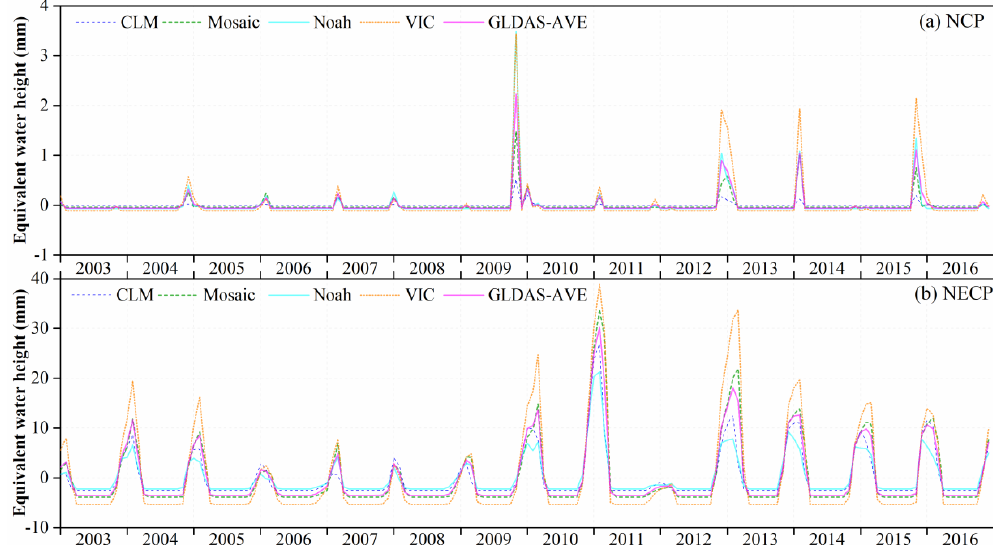
Figure 3. Monthly time series of soil moisture storage anomalies (SMSA) from four Global Land Data Assimilation System (GLDAS) models (CLM, Mosaic, Noah, VIC) and their average (GLDAS-AVE) compared with in situ data in the NCP ( a ) and NECP ( b ).